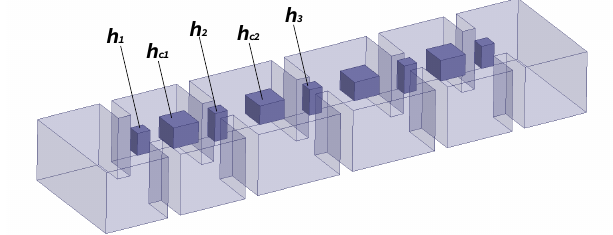
Figure 7. Geometrical variables and 3D configuration of the four-order bandpass filter